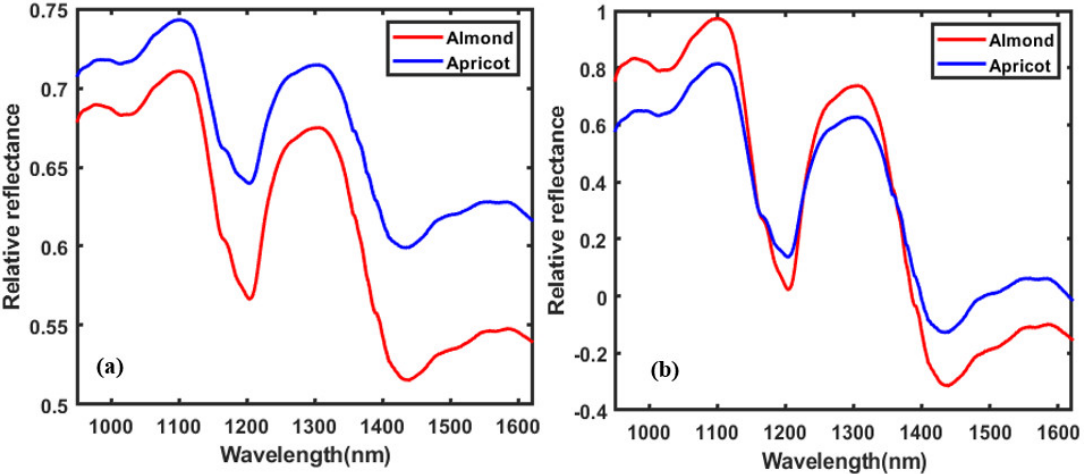
Figure 4. The plots present ( a ) mean data obtained before treatment and ( b ) the SNV preprocessing mean data plot in the range of 950–1622 nm.